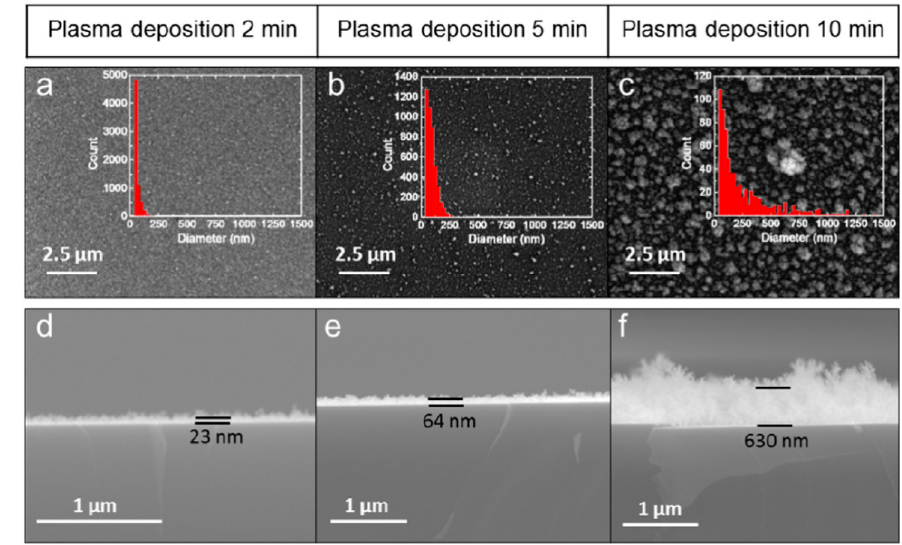
Figure 4. Surface morphology of TiO 2 films on a Si wafer with increasing deposition time ( a – c ). Insets showing histograms of particle size distribution. As the deposition time increases, the film thickness and roughness increase ( d – f ). These scanning electron microscopy (SEM) images were reprinted from [75], with permission from Elsevier.